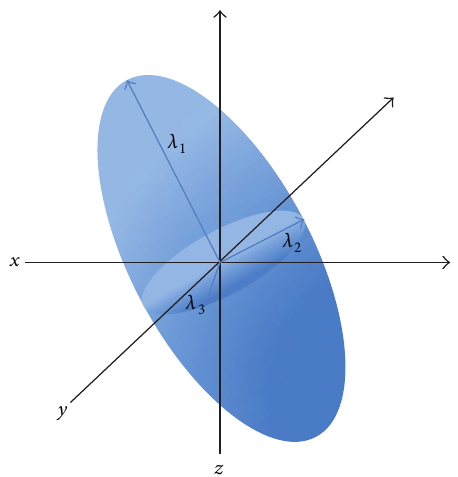
Figure 1: Elliptical representation of a diffusion tensor with the 3 main axes: the longest axis stands for the primary eigenvector ( 𝜆 1 ), reflecting the diffusion parallel to the fibers; the two shorter axes representthesecond( 𝜆 2 )andthird( 𝜆 3 )eigenvectors,whoseaverage provides a measure of diffusivity perpendicular to the